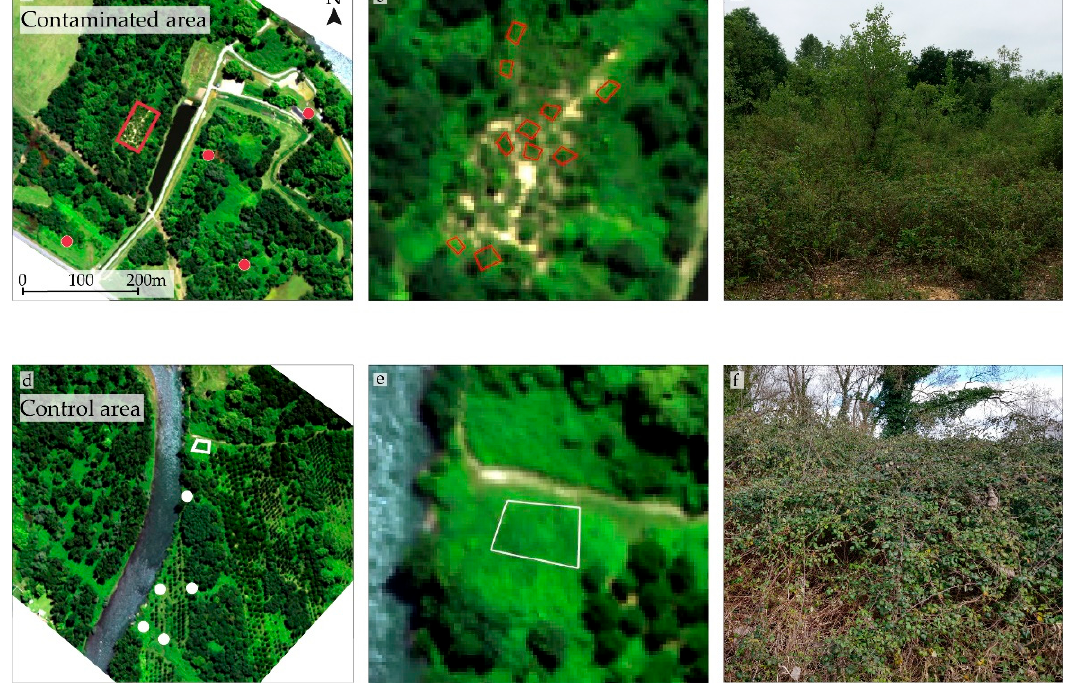
Figure 1. ( a , d ) Subsets of the airborne hyperspectral image acquired over ( a ) the contaminated and ( d ) the control sites. The calibration sites are illustrated by polygons. Circles correspond to the validation sites (red: contaminated, white: control). ( b , e ) Zoom on ( b ) the brownfield (10 plots) and ( e ) the control sites used for calibrating the methods, respectively. ( c , f ) R. fruticosus on ( c ) the brownfield and ( f ) on the control site in March.